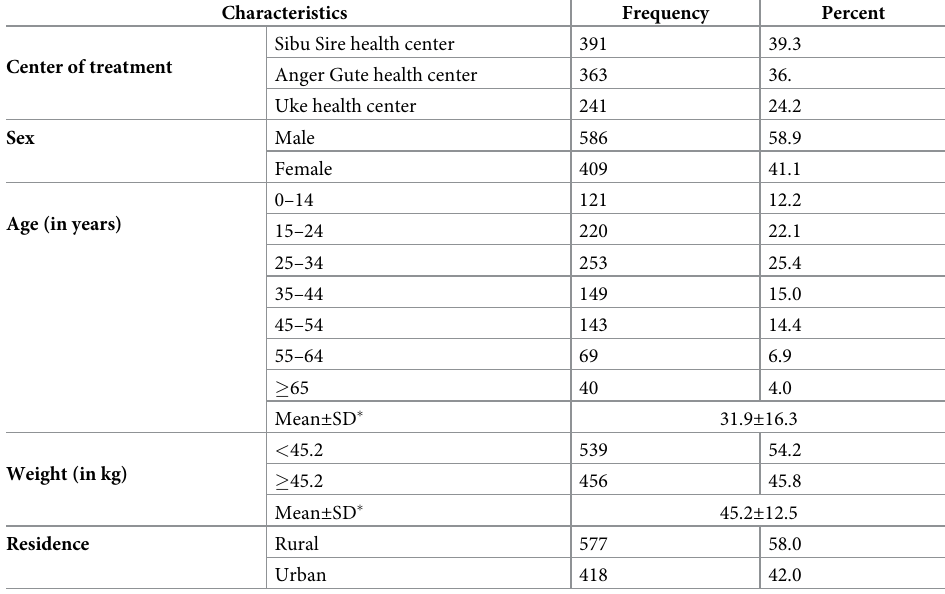
Table 1. Demographic characteristics of TB patients at three TB treatment centers in East Wollega from 2012 to 2016.